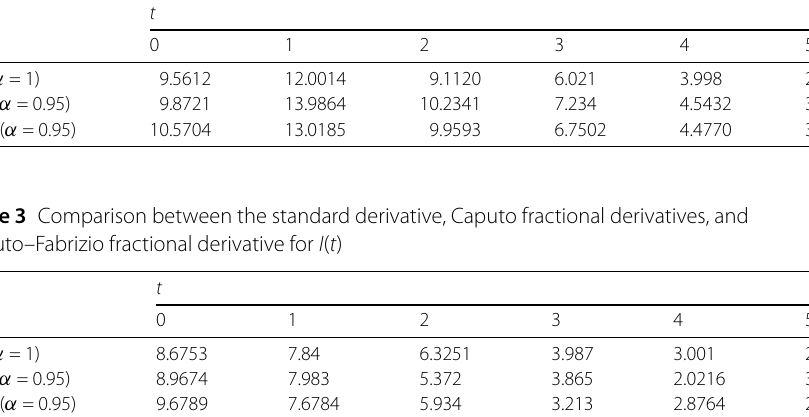
fractional-order α = 0.9,0.8,0.7,0.6 and have compared the numerical results of the stan- dard derivative with two fractional derivatives of rubella model for α =